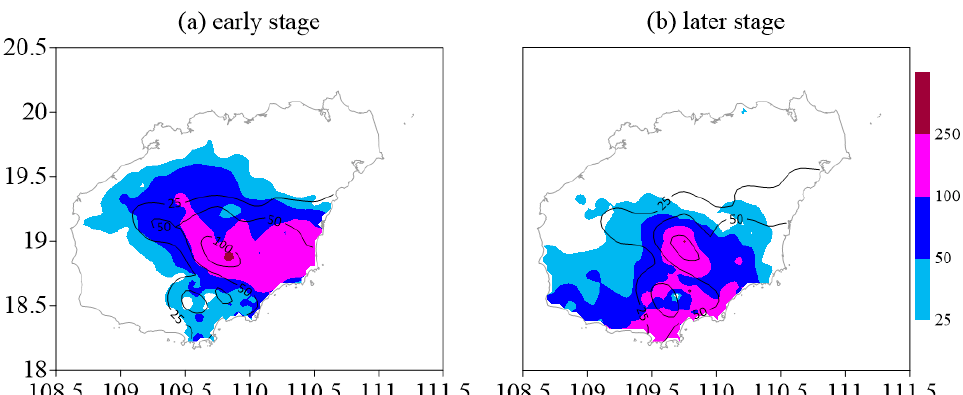
Figure 2. ( a ) Comparision of the 24 h accumulated rainfall (mm) that was initialized at 0000 UTC 16, ending 1200 UTC 17, between the observed (shaded) and the simulation (contoured) generated by the ECMWF model. ( b ) as ( a ) but ending 1200 UTC 18, initialized at 0000 UTC 17.